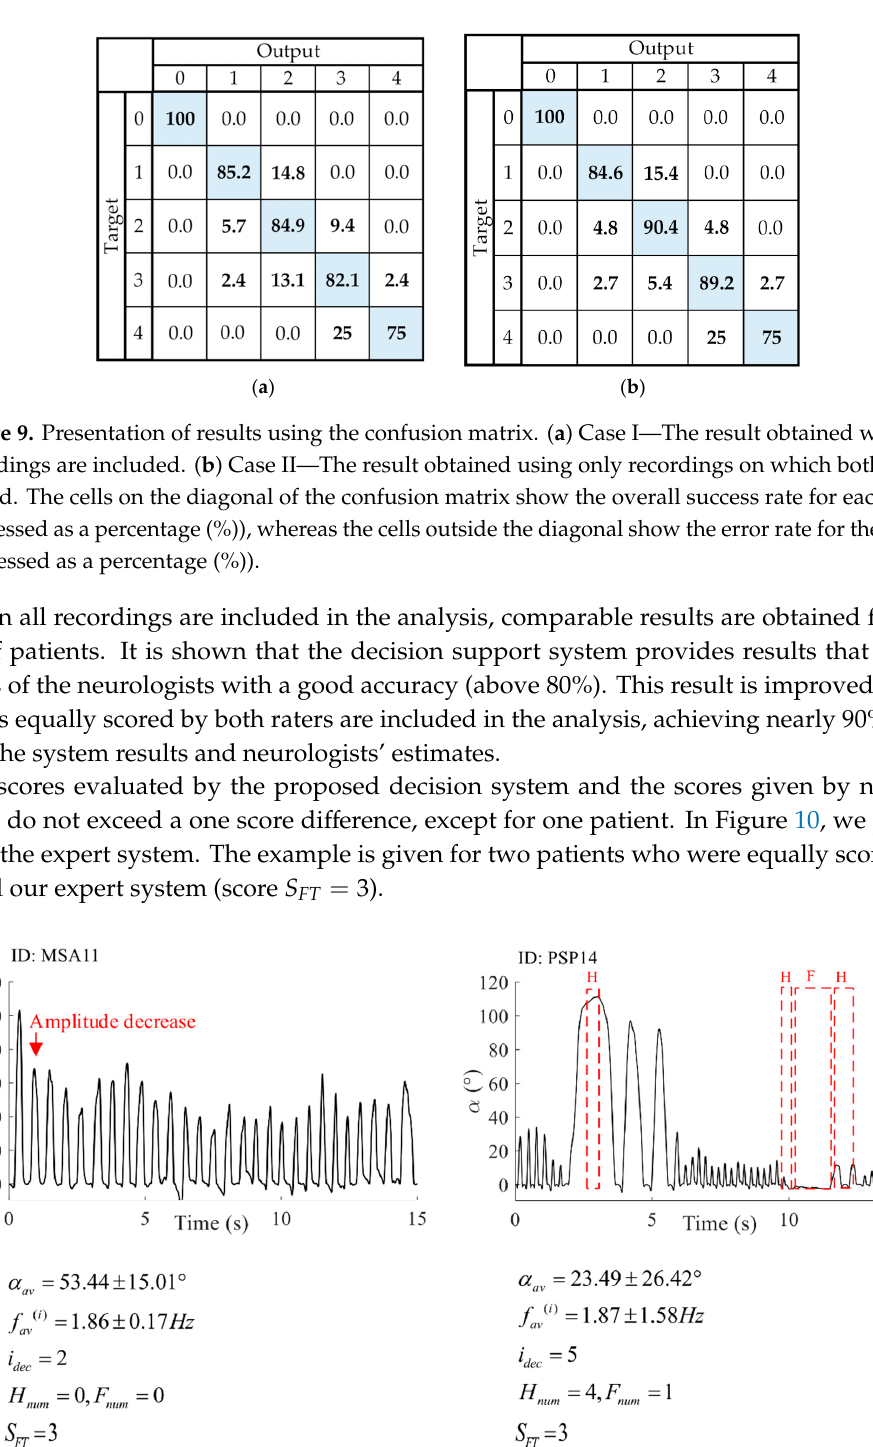
Figure 10. The result of the expert system comprising a graphical representation with detected irregularities, calculated features, and the final score. The example is given for one MSA patient (ID: MSA11), right hand, and one PSP patient (ID: PSP14), right hand.